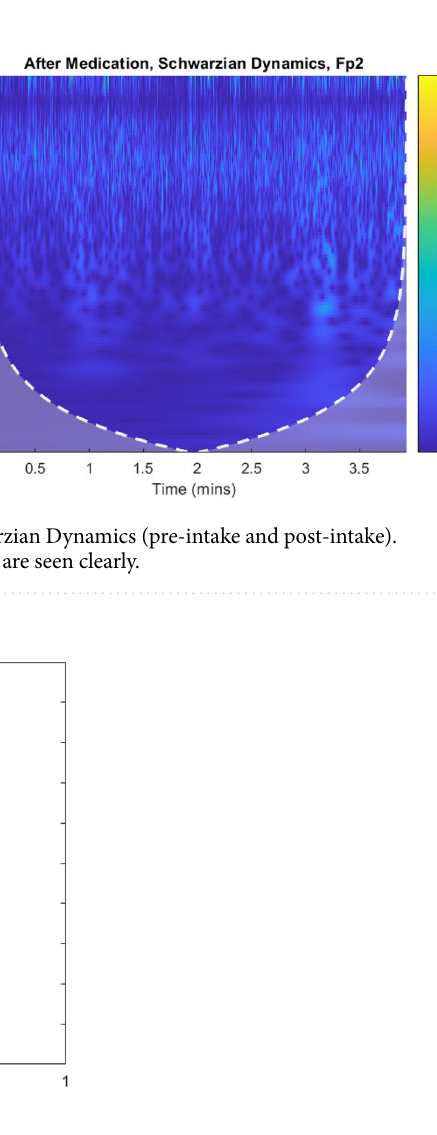
Table 1. p-associations to Wilcoxon-sign test of entropy values of Schwarzian chaos between pre- and postmedication over 10 bipolar patients for 21 electrodes each over 30,000 time points at a 125 Hz sampling frequency corresponding to 4 min. recording periods.